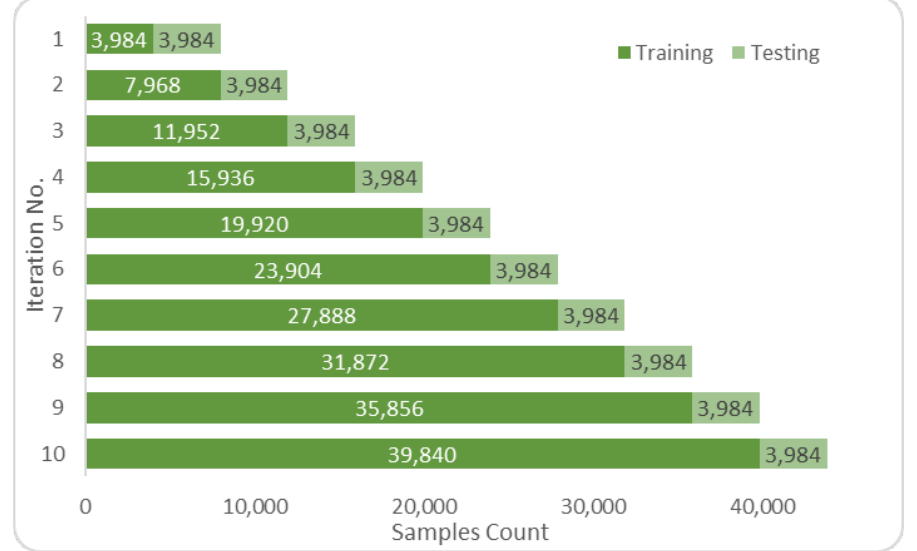
Figure 10. Training vs. testing in timeseries split cross-validation n = 10 for the Manchester dataset.